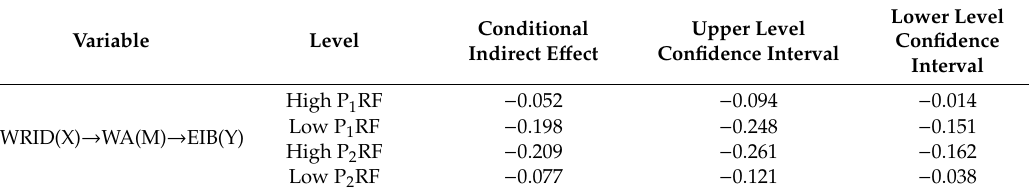
Table 3. Moderated mediation